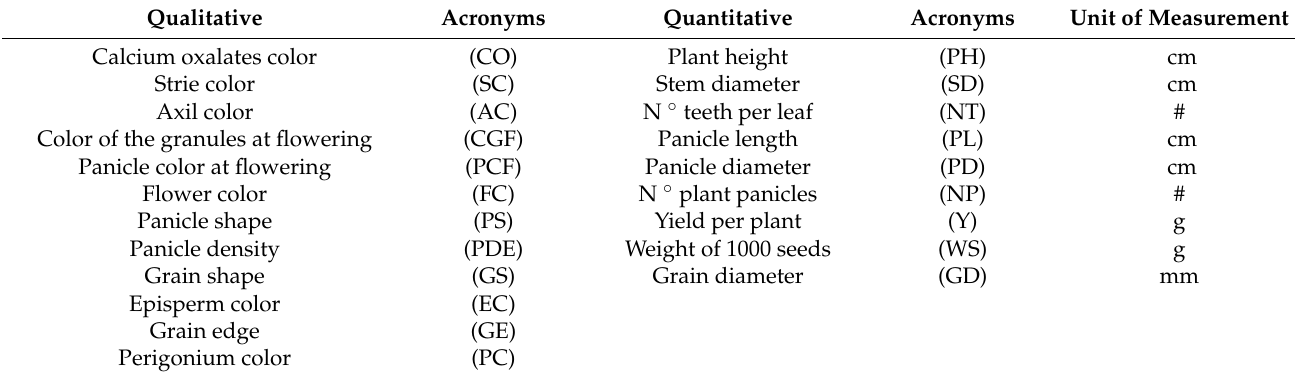
Table 3. Morphologic descriptors used for the characterization of quinoa accessions from the Department of Boyac á .